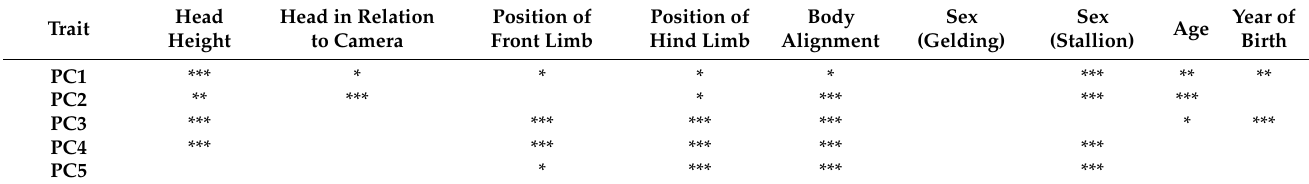
Table 4. Summary table of the significance of the postural variables, sex, age and year of birth on the different joint angles based on linear regression.